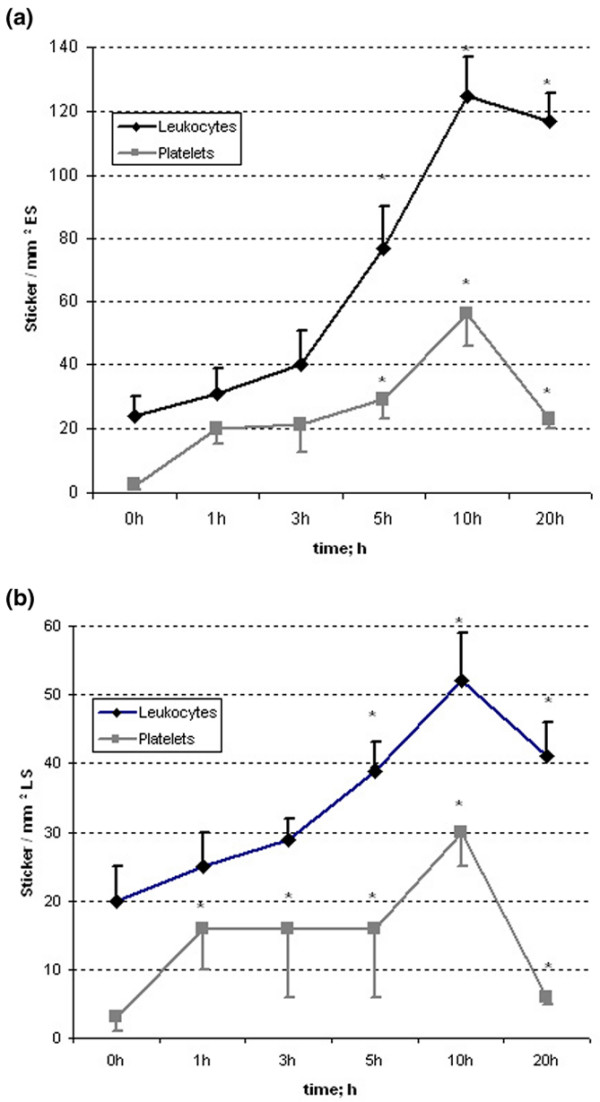
Sticking leukocytes and platelets in (a) postsinusoidal venules and (b) hepatic sinusoids. Asterisks indicate p < 0.05 versus 0 h. ES, endothelial surface; LS, liver surface.